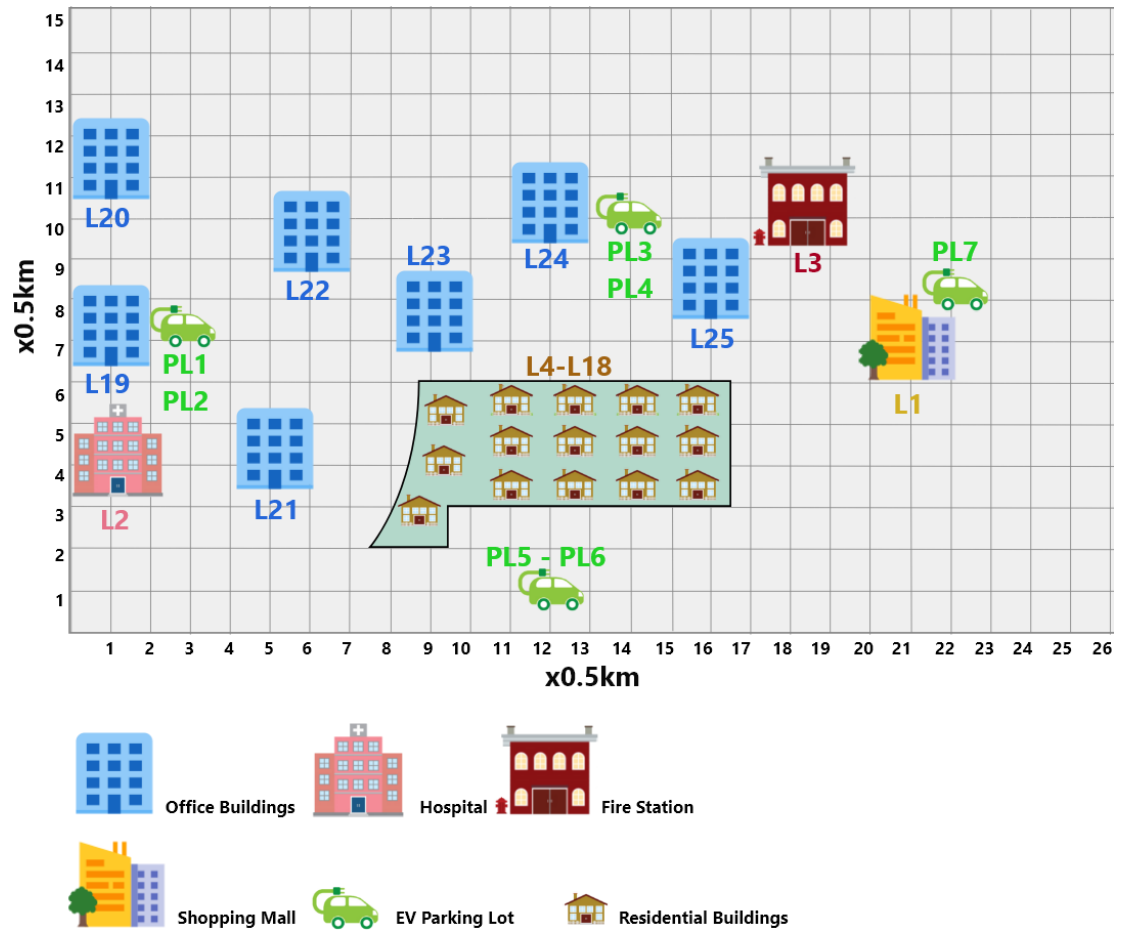
Figure 5. Smart city